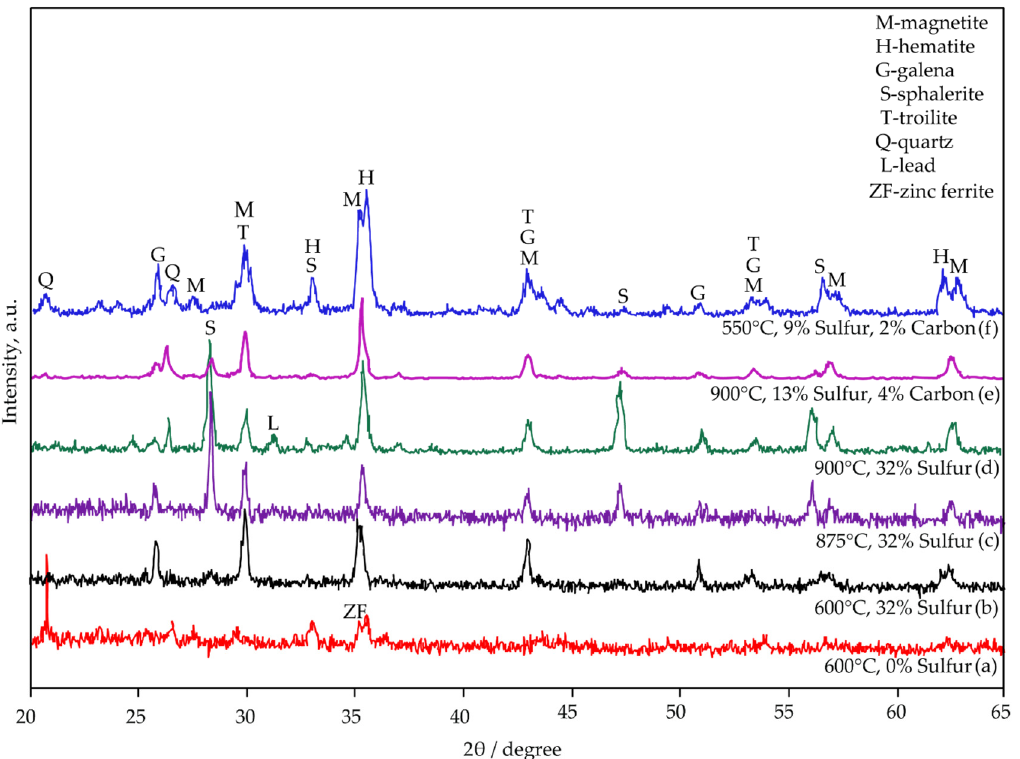
Figure 15. XRD patterns of sulfidized samples. Jarosite roasted at 600 °C ( a ), jarosite with 32.00% of added sulfur roasted at 600 °C ( b ), 875 °C ( c ), 900 °C ( d ), jarosite with 13.00% of sulfur and 4.00% of added carbon roasted at 900 °C ( e ), and jarosite with 9.00% of sulfur and 2.00% of added carbon roasted at 550 °C ( f ).